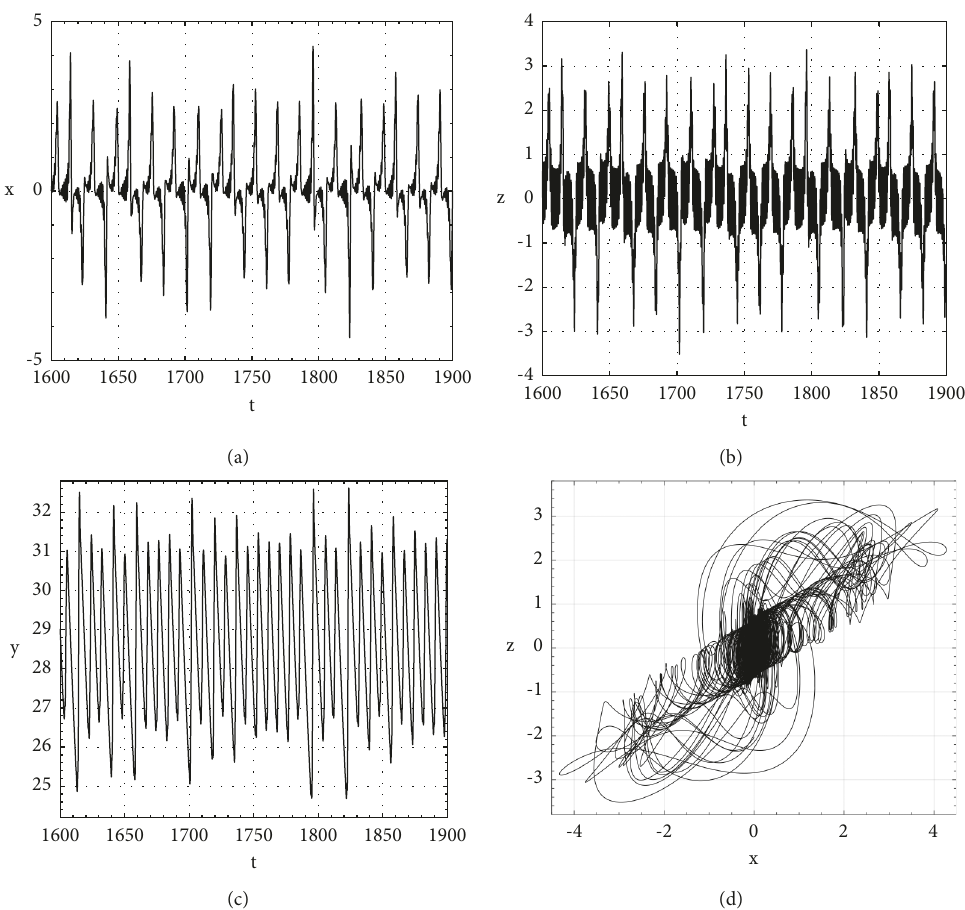
Figure 11: Time series (a), (b), (c), and phase portrait in plant ( z , x ) (d) of bursting phenomena obtained when the amplitude of the sinusoidal load torque is T 3 � 4.6959. The frequency is F � 50Hz, and the rest of parameters are the same as in Figure